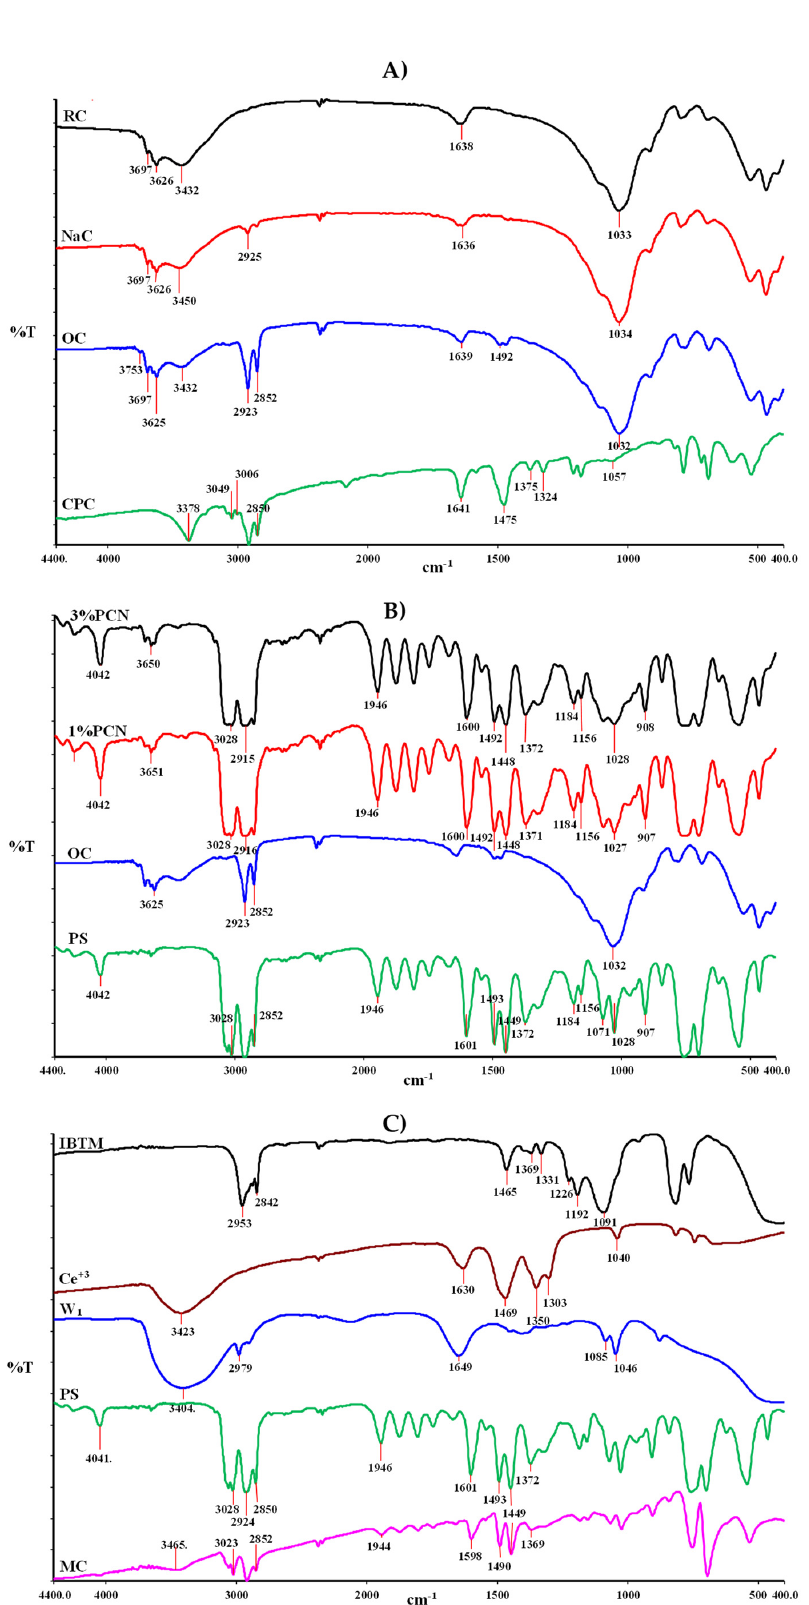
Figure 1. FT-IR of ( A ) RC, NaC, OC and CPC, ( B ) OC, PS, 1% PCN and 3% PCN, and ( C ) PS, Ce +3 , IBTMS, and MC.